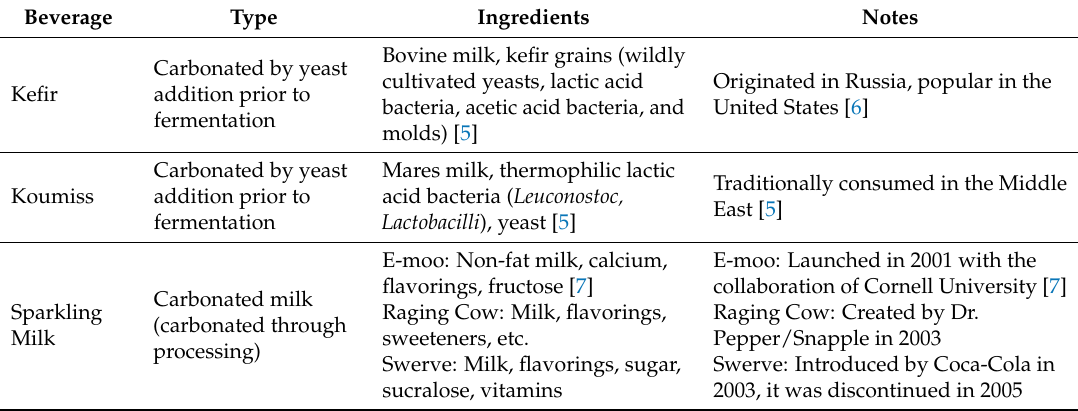
Table 1. Carbonated dairy